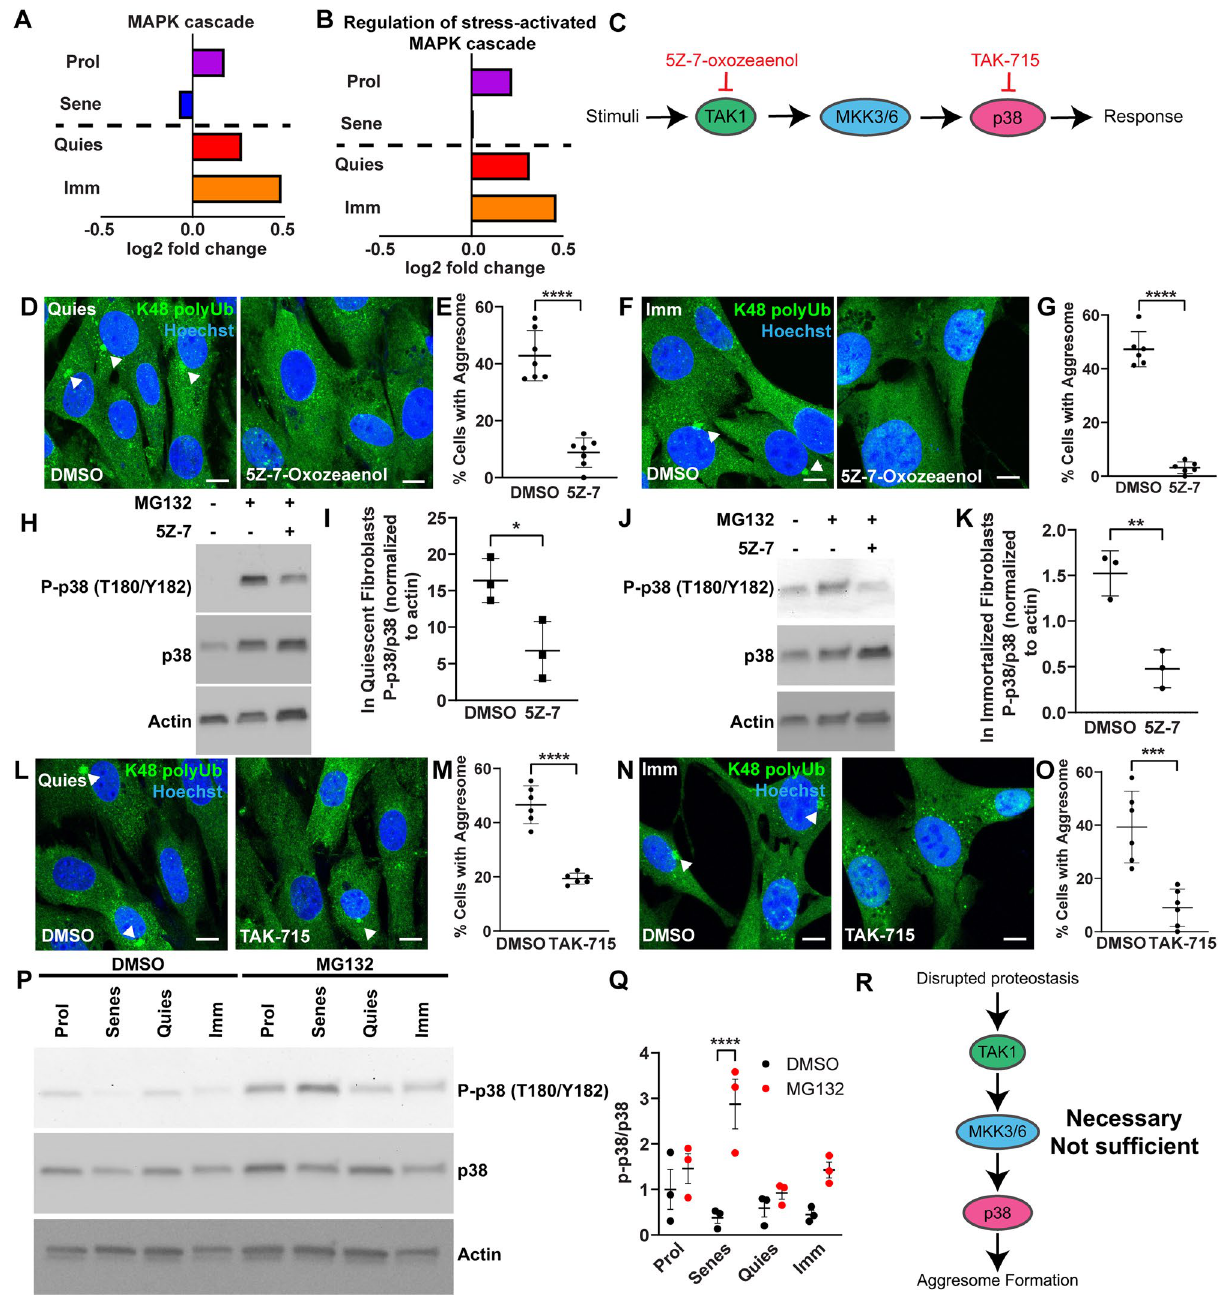
Figure 4. p38α MAPK and p38β MAPK inhibition with TAK-715, and TAK1 inhibition with 5Z-7 suppress aggresome formation in fibroblasts. ( A , B ) Average DESeq2 log2(fold change) values for all MAPK cascade or Regulation of stress-activated MAPK cascade genes as proliferating (purple), senescent (blue), quiescent (red), and immortalized (orange) fibroblasts respond to MG132 treatment. ( C ) A schematic summarizing the interaction of TAK1, MKK3/6 and p38 MAPKs in stress-activated MAPK signaling. Inhibitors are shown in red. ( D – G ) Quiescent and immortalized fibroblasts were treated with 5 µg/mL 5Z-7 or 0.05% DMSO for 24 h, and then additionally treated with 10 µM MG132 for 7 h still in the presence of 5Z-7 or DMSO prior to being immunostained for K48 polyUb (green) and Hoechst (nucleus; blue). Samples were analyzed for the proportion of cells forming the aggresome (N = 3; Student’s t-test; mean ± SD). ( H – K ) Quiescent and immortalized fibroblasts were treated with 10 µM MG132 and/or 5 µg/mL 5Z-7-Oxozeaenol for 8 h as above and then analyzed for expression of p38 MAPKs, actin, and P-p38 MAPKs (T180/Y182) by western blot. (N = 3; two-way ANOVA with post-hoc Tukey’s test; mean ± SD). ( L – O ) Quiescent and immortalized fibroblasts were treated with 50 µM TAK-715 or 1% DMSO for 24 h, then additionally treated with 10 µM MG132 for 7 h still in the presence of TAK-715 or DMSO prior to being immunostained for K48 polyUb (green) and Hoechst (nucleus; blue). Samples were analyzed for the proportion of cells forming the aggresome (N = 3; Student’s t-test; mean ± SD). ( P , Q ) Proliferating, senescent, quiescent, and immortalized fibroblasts were treated with 0.1% DMSO or 10 µM MG132 for 8 h prior to analysis of p38 MAPKs, and P-p38 MAPKs (T180/Y182) by western blot. A ratio of P-p38/total p38 was used to measure activation of p38 (N = 3; Two-way ANOVA with post-hoc Tukey’s test; mean ± SD). ( R ) A schematic depicting a working model for p38 MAPK’s role in aggresome formation in primary mouse dermal fibroblasts, suggesting p38 activity is necessary but not sufficient. Scale bars 10 µm. *p < 0.05, **p < 0.01, ***p < 0.001, ****p <